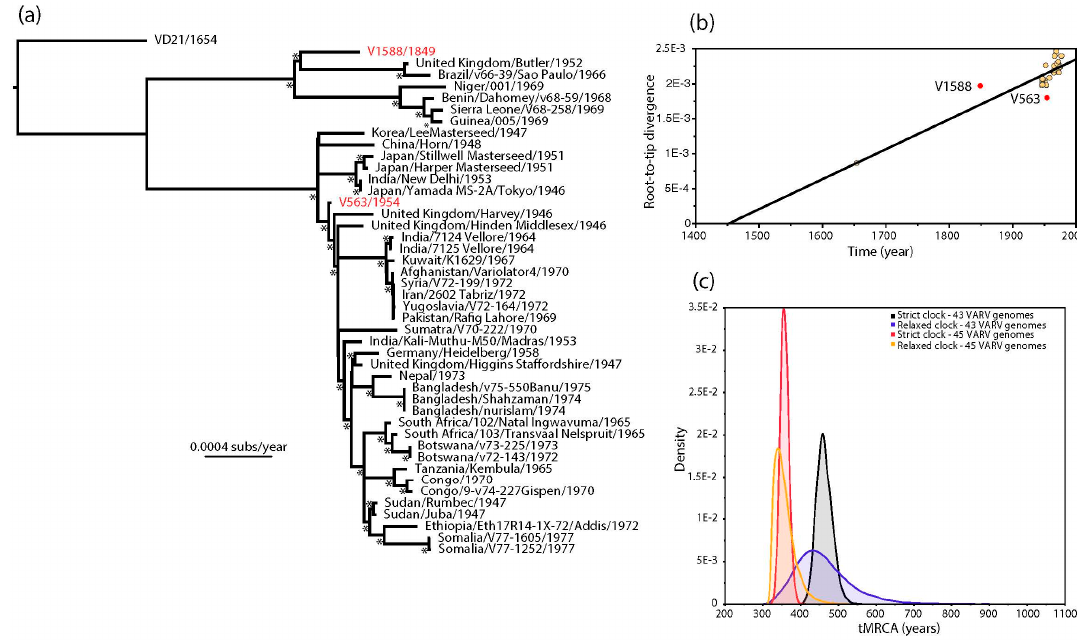
Figure 1. ( a ) Maximum likelihood (ML) phylogenetic tree of 45 complete genomes of VARV. The phylogeny was based on a complete genome alignment of 181,261 bp constructed using a combination of MAFFT [11] and GBlocks [12] pruning to remove ambiguously aligned regions. The phylogeny was inferred using PhyML [13] assuming the General Time Reversible (GTR) model of nucleotide substitution, with a proportion of invariable sites (I) and a gamma distribution ( Г ) of among-site rate variation. All horizontal branch lengths are scaled according to the number of nucleotide substitutions per site, and bootstrap values >90% are marked with a * symbol. The tree is rooted using a sequence obtained from a Lithuanian mummy (VD21) and V1588 and V563 are shown in red; ( b ) regression of root-to-tip genetic distances from the ML tree against their sampling year. V1588 and V563 are shown in red. This analysis was performed using the TempEst program [14]; ( c ) bayesian estimates of times to common ancestry in VARV. The ’45 VARV’ estimates utilized the tip times in the full 45 genome sequence data set, incorporating mean age estimates of 1849 and 1954 for V1588 and V563, respectively, that are taken from the distribution of possible racemization-based dates provided by Pajer et al. [1]. The ’43 VARV’ estimates are those in which a uniform prior distribution with bounds of 0 and 1.0E10 was specified for the ages of V1588 and V563, with these and all other parameter values inferred from the remaining 43 sequences in the alignment. All these analyses were performed using the BEAST package [8], run for 100 million generations, and employing a constant population size (XML files are available in the supplementary material).